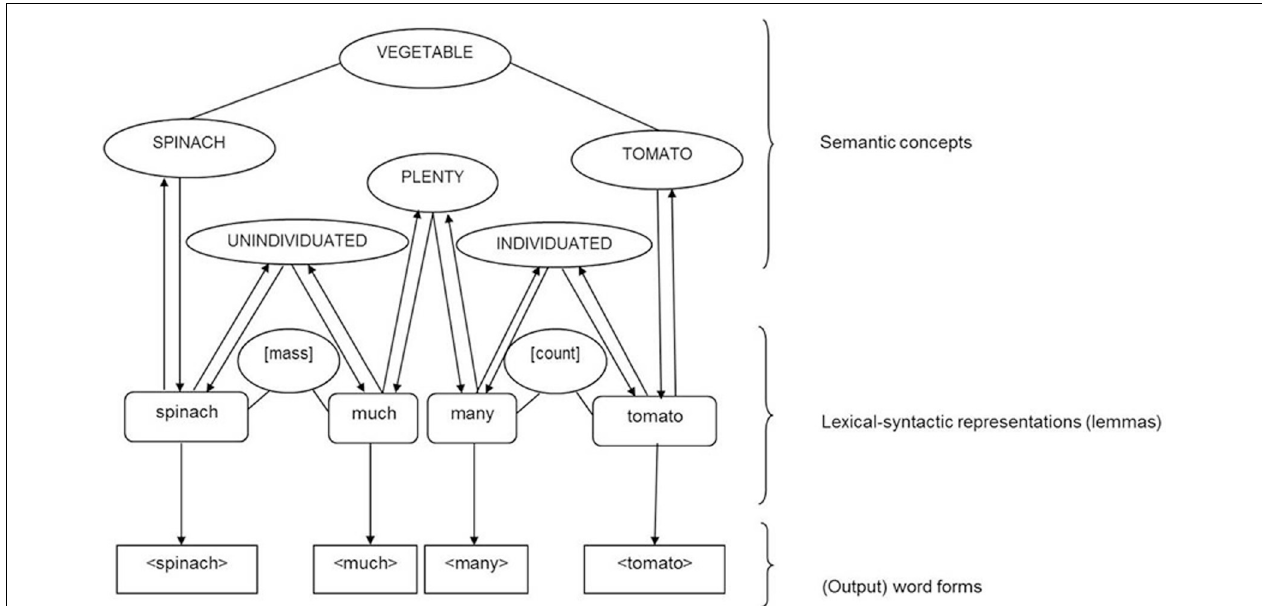
FIGURE 11 | Illustration of the processing and representation of mass nouns (e.g., spinach) and count nouns (e.g., tomato) in a theory of language production derived from Levelt et al.’s (1999) theory, with separate count and mass properties at the